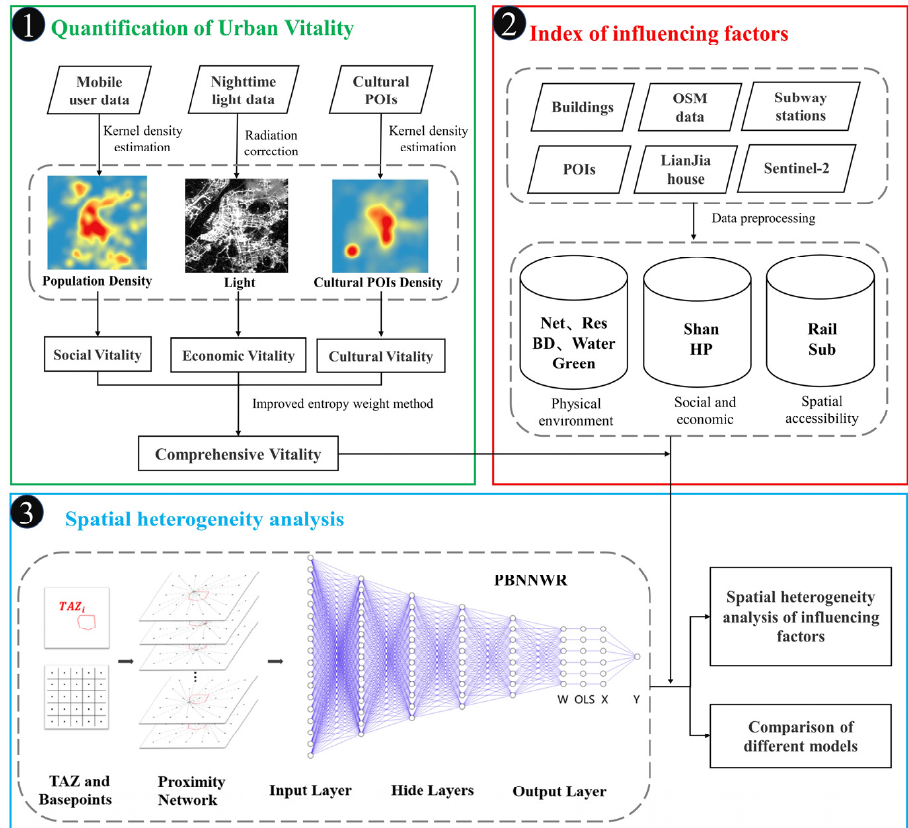
Figure 3. The analytical framework for urban vitality.